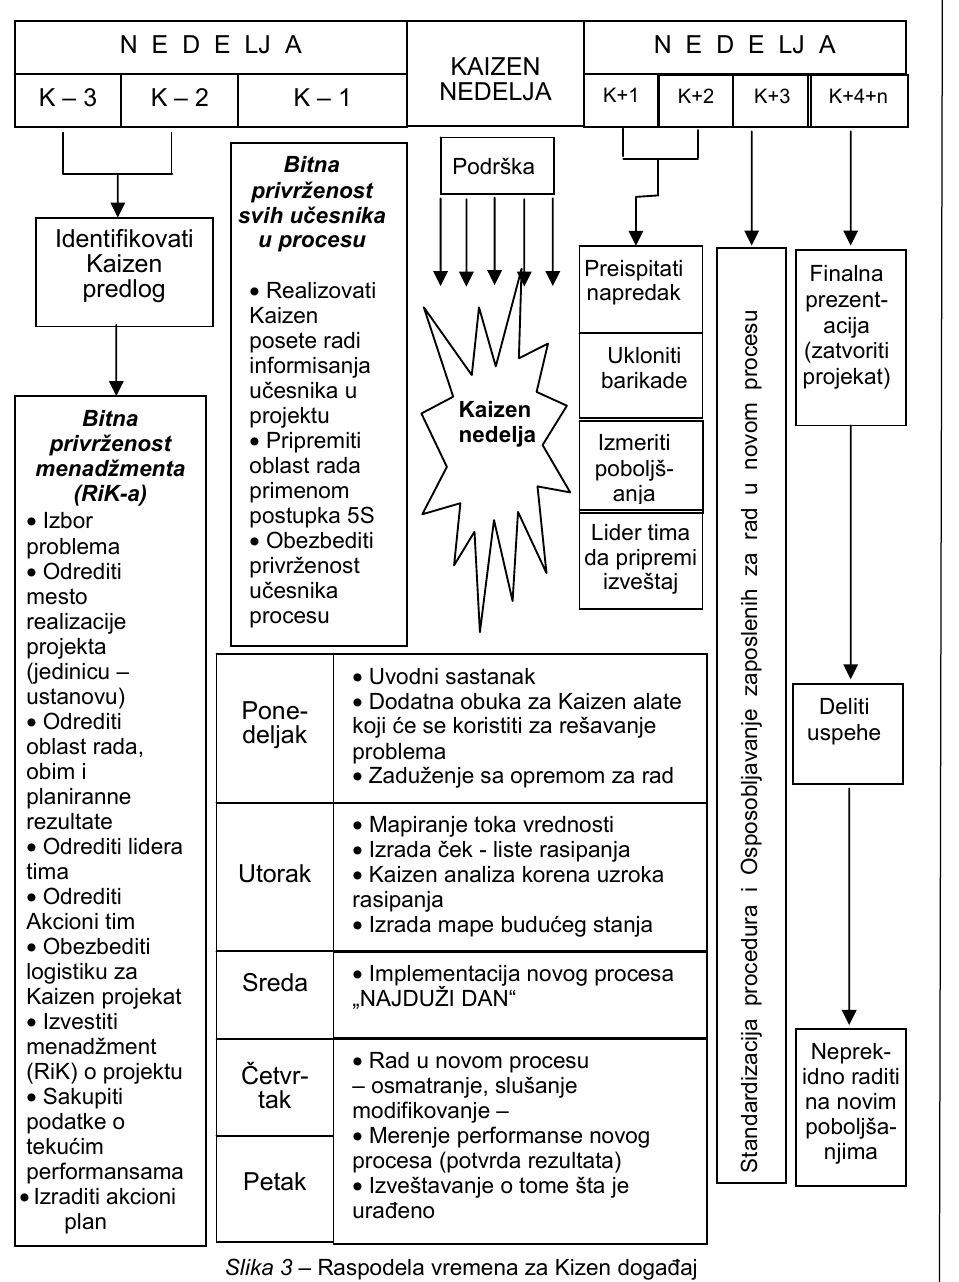
Рис . 3 – Распределение времени по Кайдзен